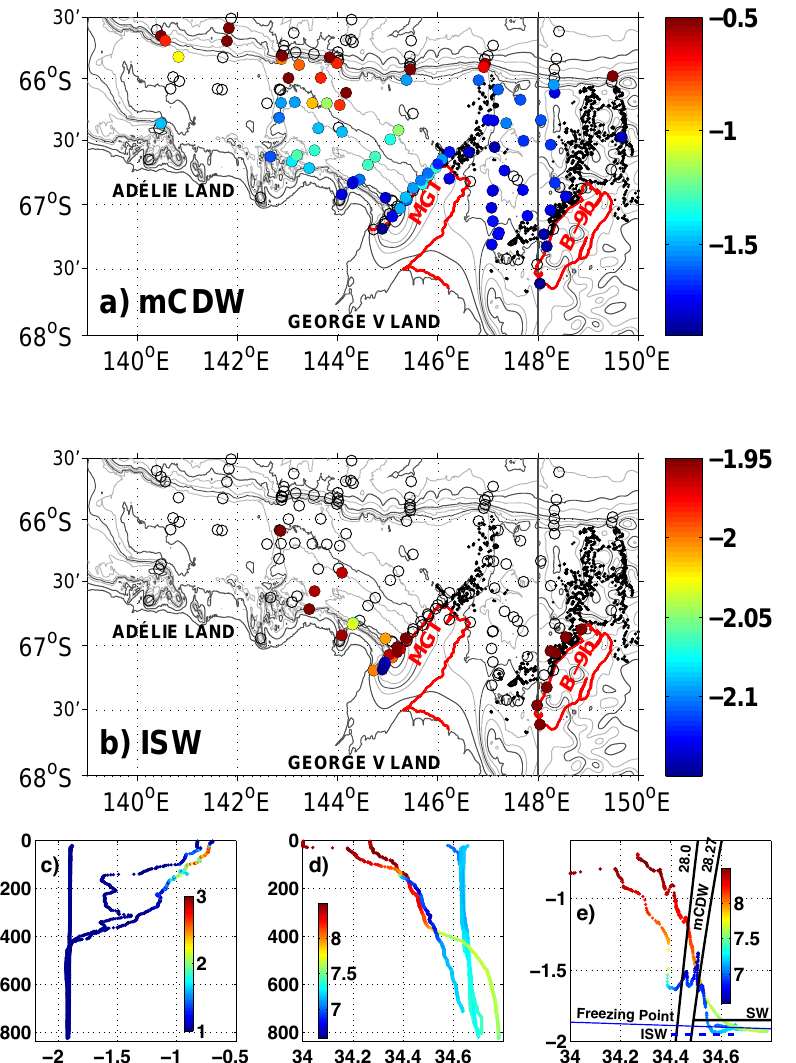
Fig. 4. Summary of regional water masses and seasonal stratification from historical ship-based CTD data. Planform distribution of (a) mCDW and (b) ISW from the NBP00–08 summertime CTD surveys. MCDW intensity indicated by potential temperature ( ◦ ) at the dissolved oxygen minimum within the mCDW layer (28.00 < γ n < 28 . 27). ISW intensity shown as potential temperature ( < -1.94 ◦ C). Panels c–e shows characteristic vertical profiles and θ − S diagrams for summer (stations 17 and 61 from NBP00–08 in Commonwealth Bay) and winter (stations 27, 51 and 84 from A9901 over the Ad´elie Depression north of Watt Bay). Color scale is raw CTD-fluoresence for the vertical profile of potential temperature and dissolved oxygen (mLL − 1 ) for salinity and the θ − S diagram. In Fig. 4e, the black contours of γ n = 28.00 and 28.27kgm − 3 define the mCDW layer and the black horizontal line is the maximum temperature ( θ < = − 1 . 85) for Shelf Water. The thick dashed blue line is the maximum temperature ( θ < =− 1 . 95 ◦ C ) for ISW and the thin blue line is the surface freezing